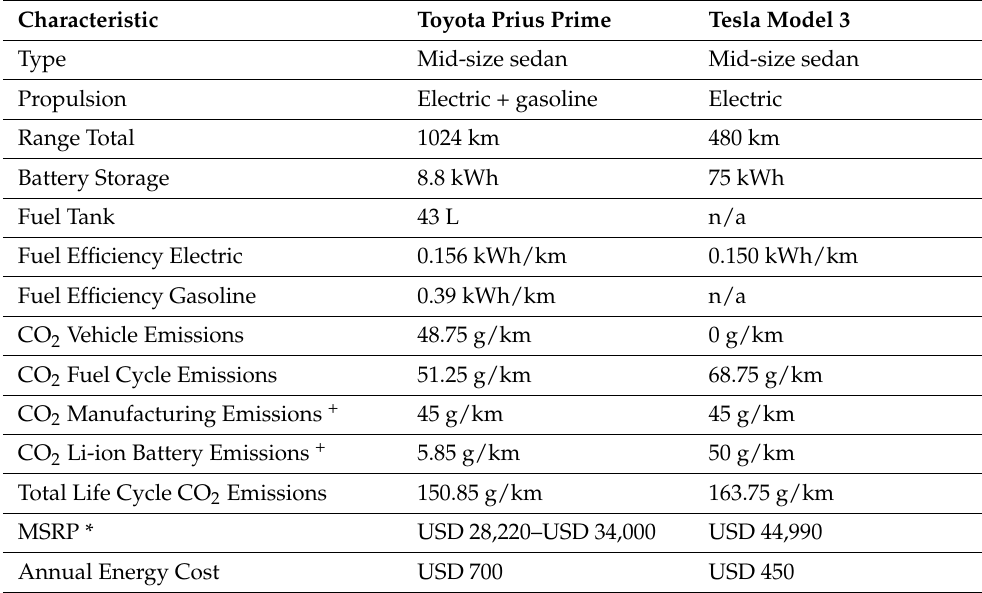
Table 6. Comparison of the key characteristics of a PHEV production vehicle (Toyota Prius Prime) and a BEV (Tesla Model 3) production vehicle in the